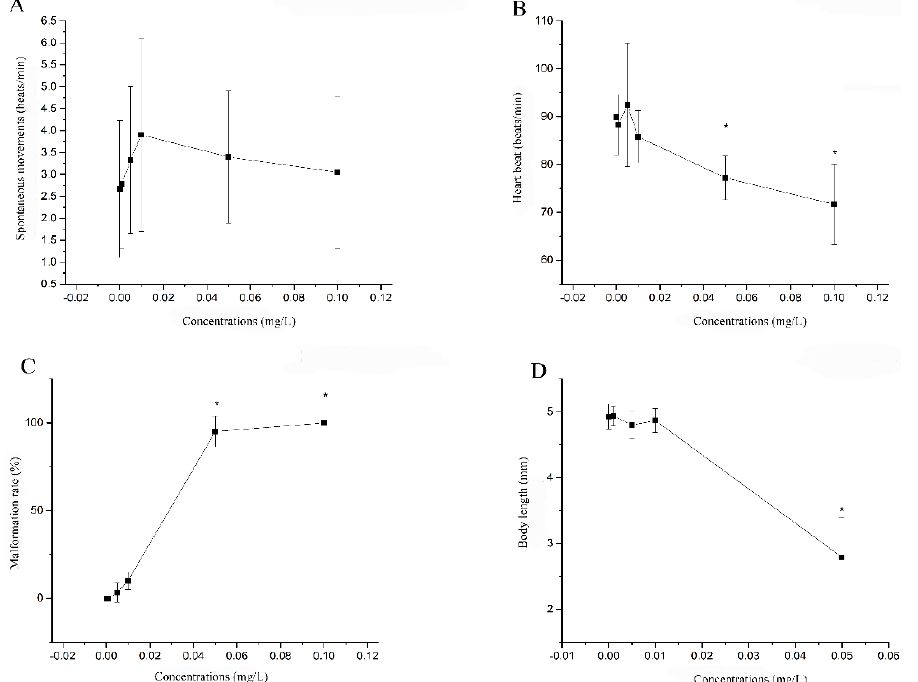
Figure 1. Sub − lethal effects of Hg 2+ on rare minnow embryo and sac − fry stages. ( A ) frequency of spontaneous movement at 36 hpf; ( B ) heart rate at 48 hpf; ( C ) malformation rate at 96 hpf; ( D ) body length of larvae after exposure. * Significant difference from the control group ( p < 0.05).